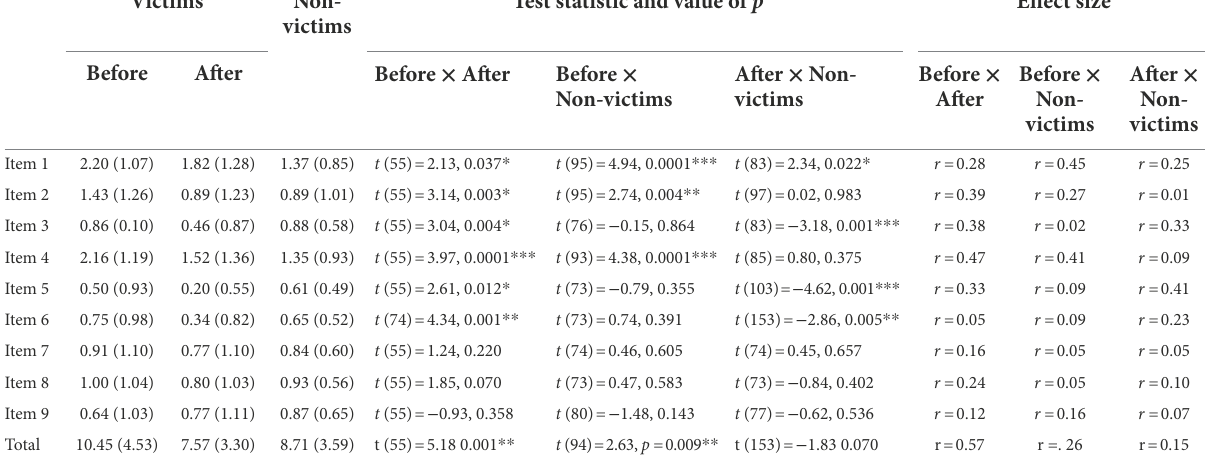
TABLE 4 Characteristics of the fraud vulnerability scale in victims and non-victims of special fraud among older